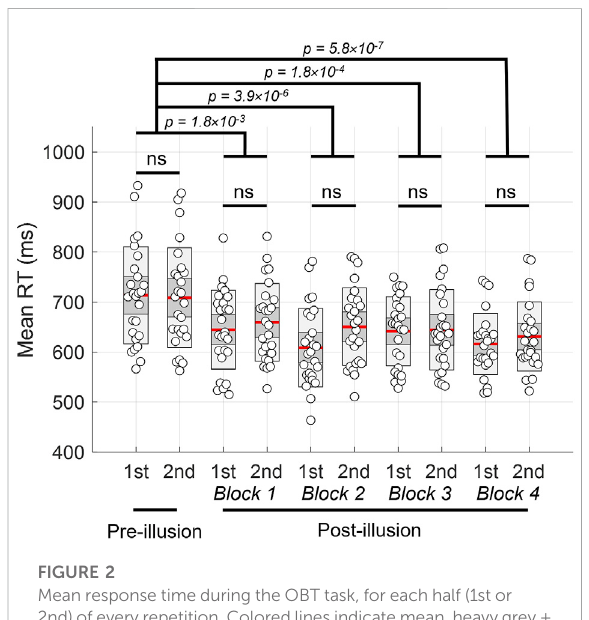
FIGURE 2 Mean response time during the OBT task, for each half (1st or 2nd) of every repetition. Colored lines indicate mean, heavy grey ± 1 SD and light gray 95% con fi dence interval. Individual values are represented by white circles.